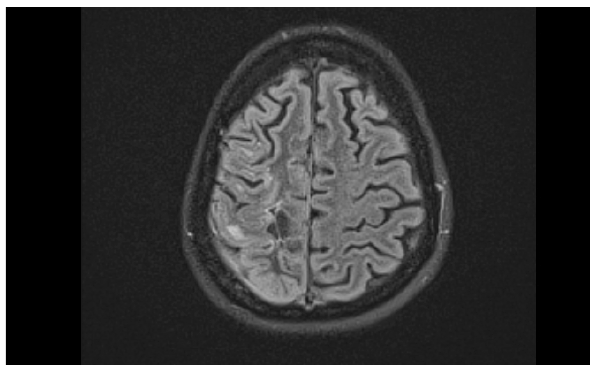
Fig. 1e. Axial T1-weighted MRI scan showing multiloculated contrast-enhanced lesions around the original resection cavity in the right parietal lobe and a blurred contrast-enhanced region in the right temporal lobe.